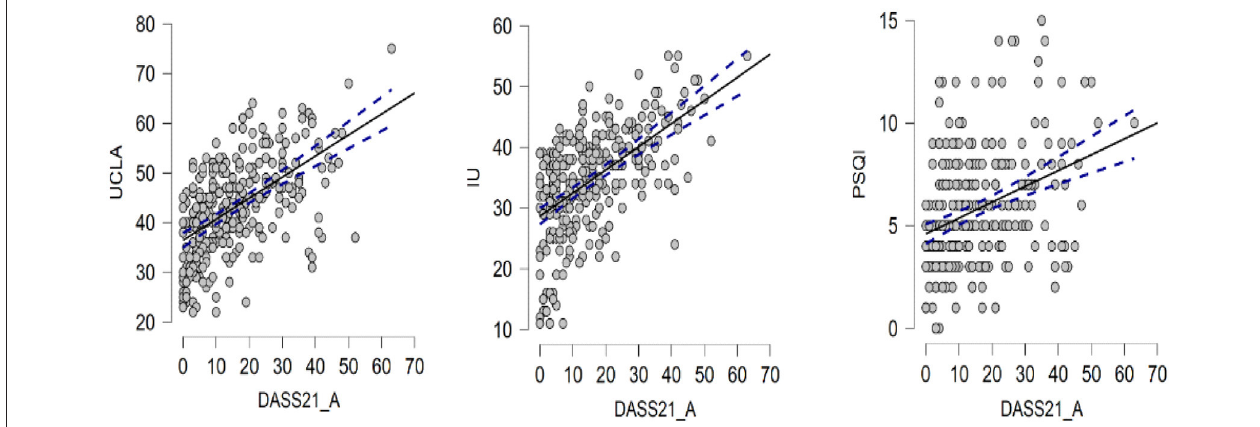
FIGURE 3 | The scatter plots among UCLA, IU, PSQI, and DASS-21.